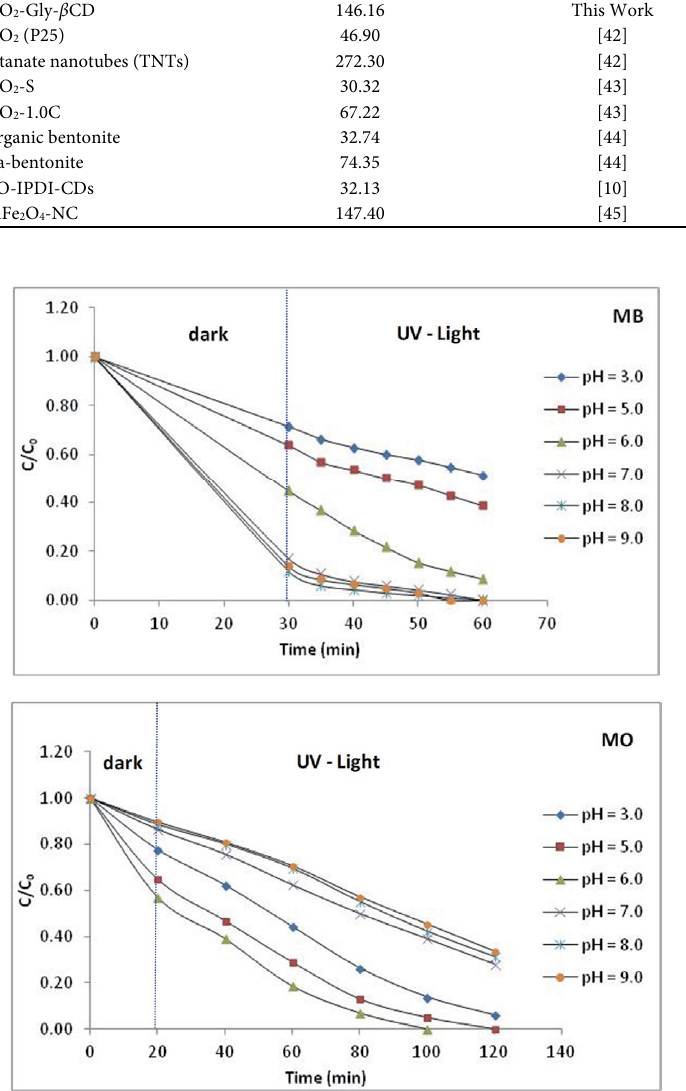
Fig. 3. Effect of pH on the photocatalytic degradation of dyes (C Fig. 3 catalyst dose = 0.01 g/l, T = 298